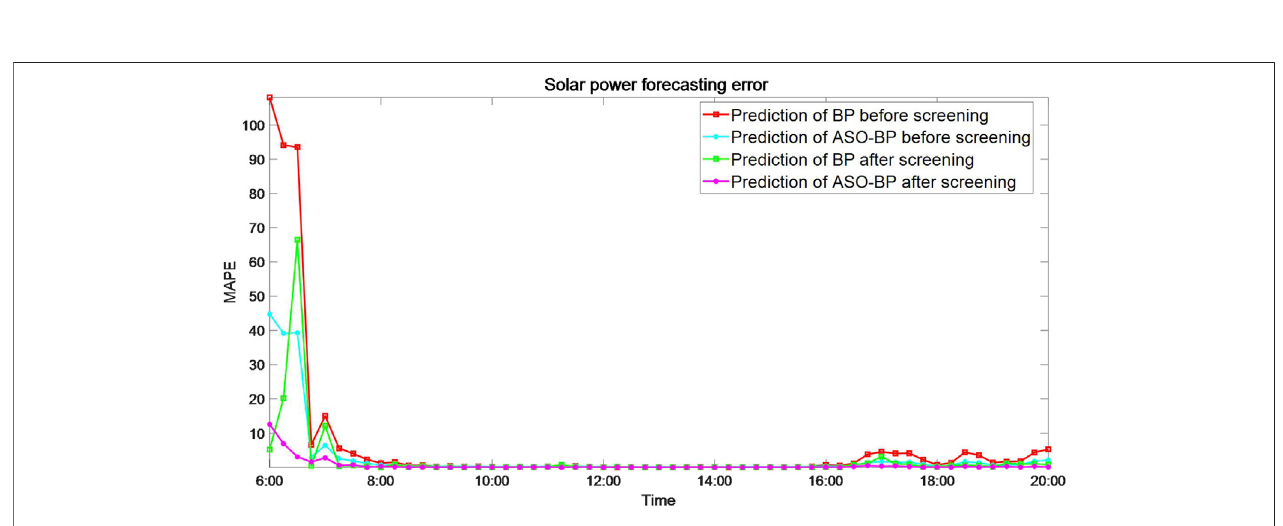
FIGURE 5 | MAPE of the two models based on two samples.